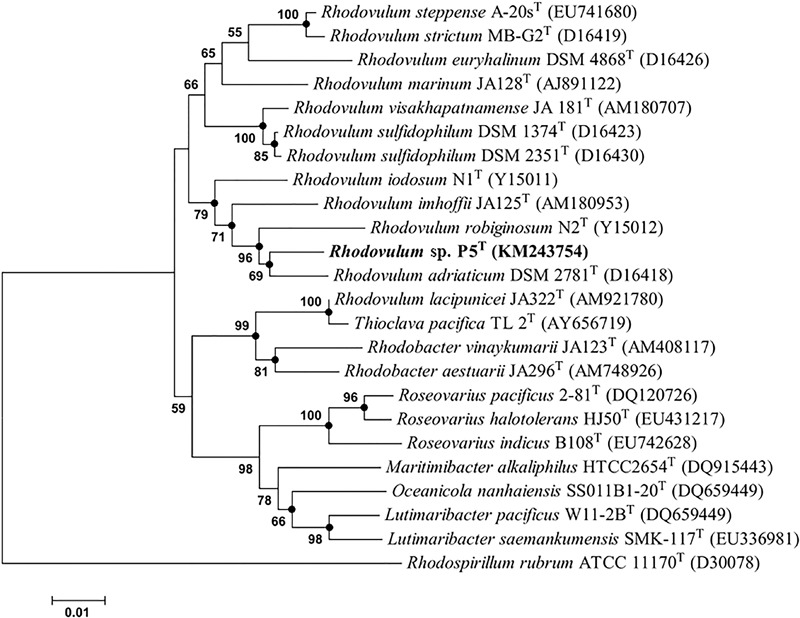
Phylogenetic tree based on alignment of 16S rRNA gene sequences showing the relationship of strain P5 (shown in bold print) within the genus Rhodovulum. The trees were constructed by the Neighbor-Joining method using MEGA version 6.0 software (closed circles represent the same tree branch using the algorithm of Maximum Likelihood and Maximum Parsimony) and rooted by using Rhodospirillum rubrum ATCC 11170T as the outgroup. Numbers at nodes represent bootstrap values (based on 100 resamplings). Bootstrap values more than 50% are noted. The GenBank accession numbers for 16S rRNA gene sequences are shown in parentheses. Bar, 1 nt substitution per 100 nt.